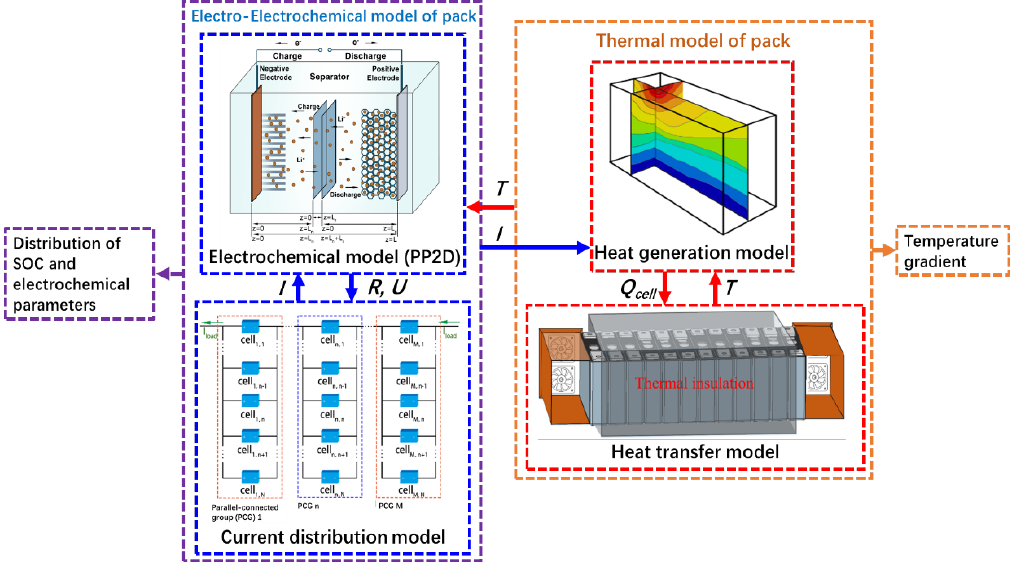
Figure 1. Structure of electro-electrochemical-thermal model for battery pack.